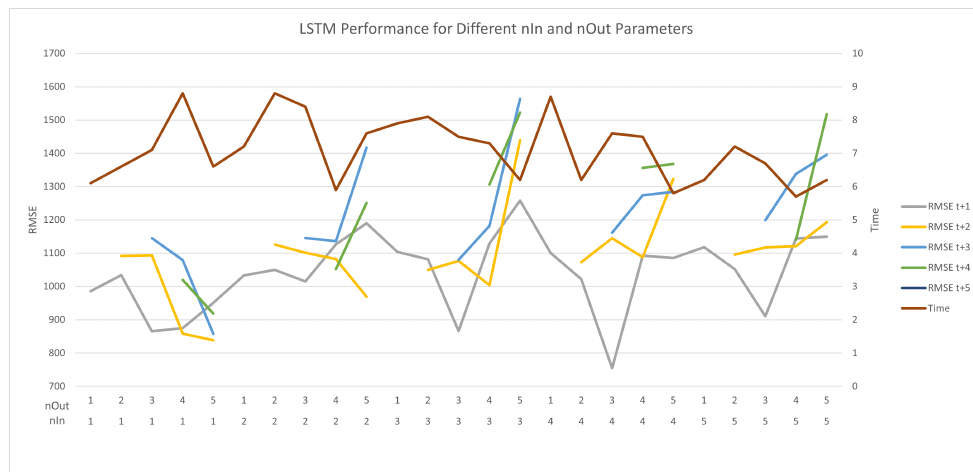
Figure 7. LSTM model performance with different nIn and nOut